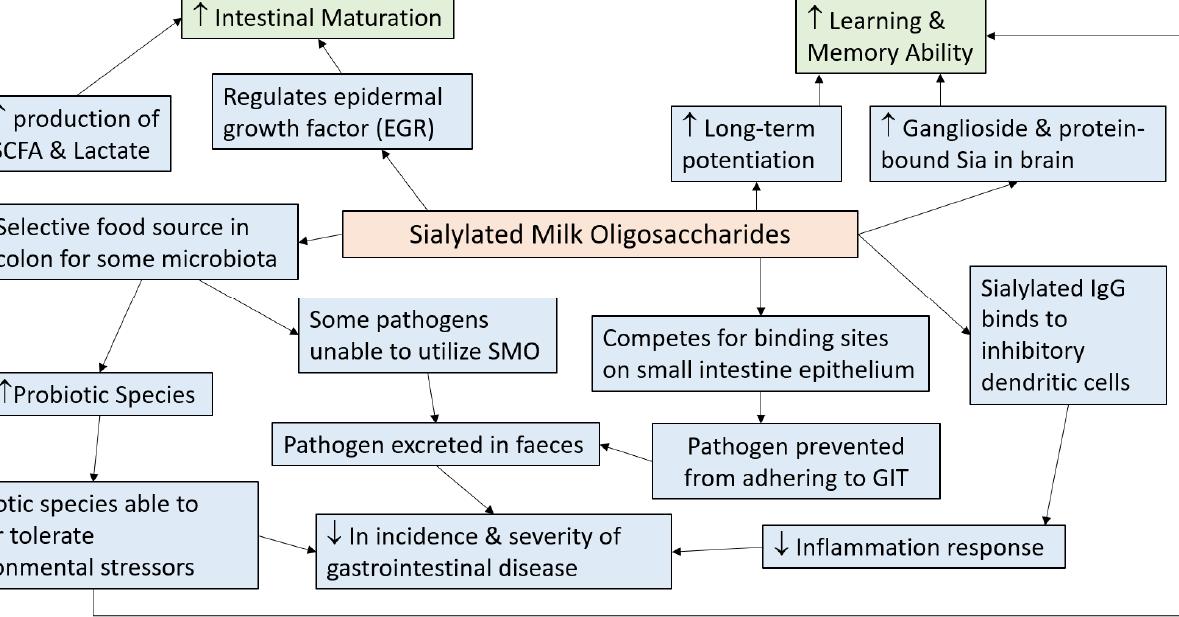
Figure 1. Summary of the pathways through which sialylated milk oligosaccharides (SMOs) exerts health benefits in humans and animals (adapted from References [16,35,100,103,106,108,109,114,148]). ↑ = increase, ↓ = decrease, GIT = gastrointestinal tract, IgG = immunoglobulin G.